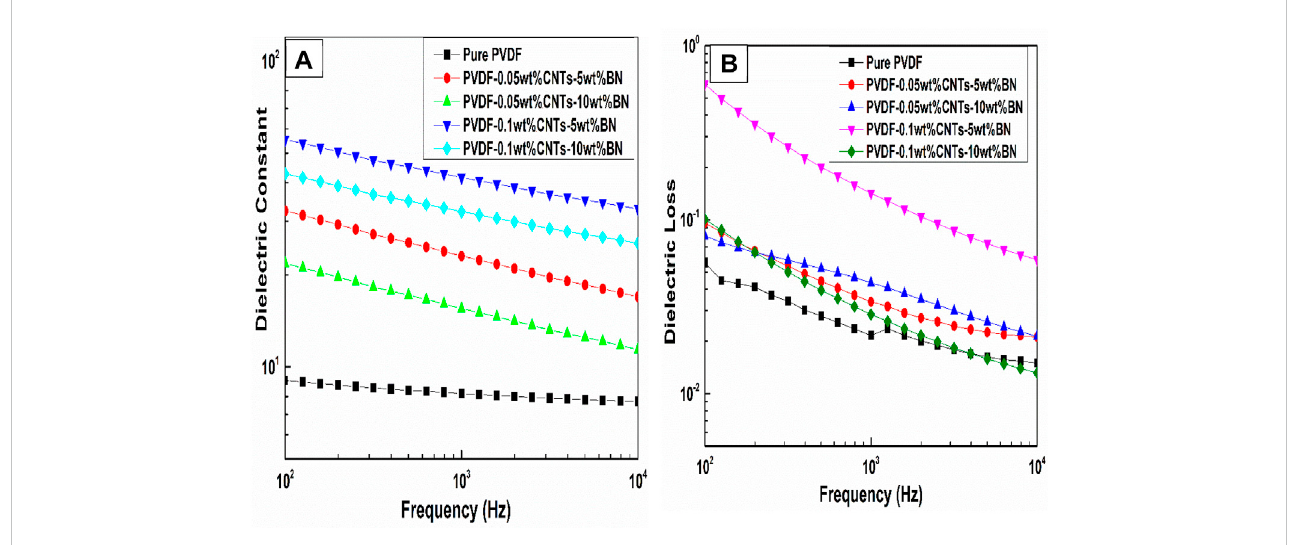
FIGURE 6 (A) Dielectric constant and (B) dielectric loss of the